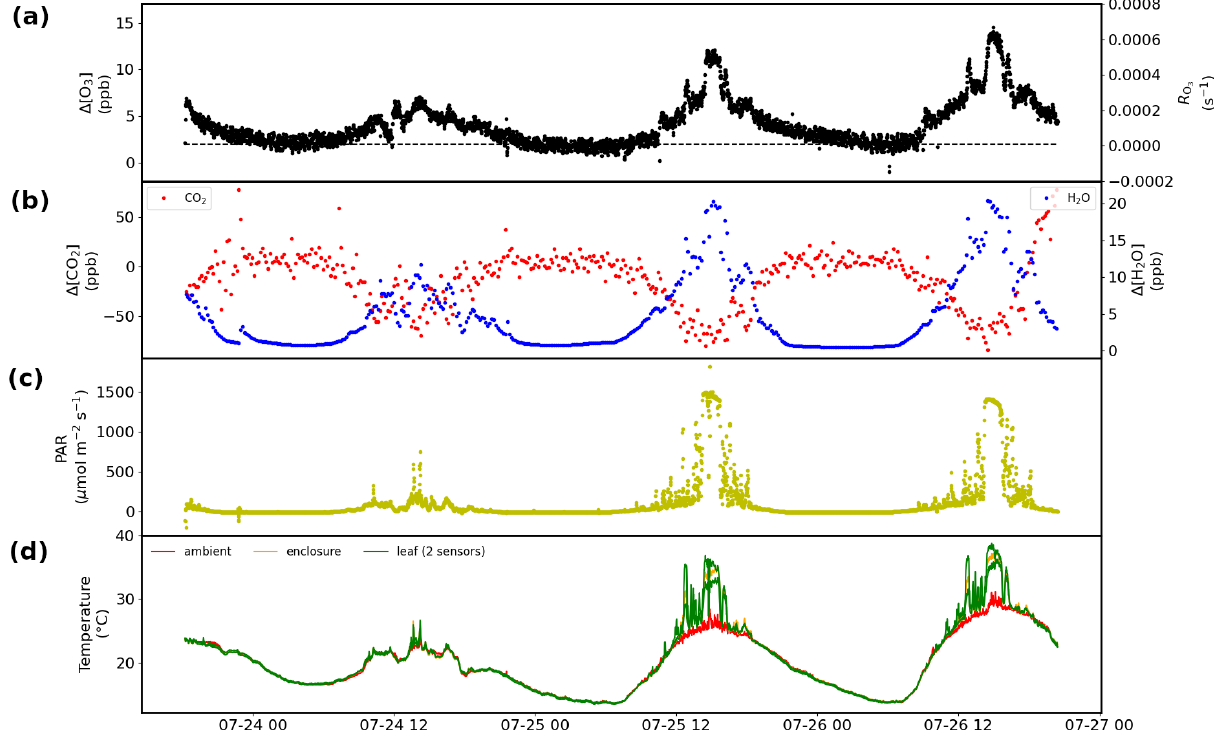
Figure 10. Results obtained over 3d from a branch enclosure experiment on a red oak tree at the University of Michigan Biological Station: (a) results for the (cid:49) [ O 3 ] measurement, with the dashed black line indicating the value of the wall losses and/or background (left) and the corresponding RO 3 (right). (b) Respiration and photosynthesis expressed as the difference in the water (right) and CO 2 (left) mole fractions in the airstream going into and out of the enclosure. (c) Solar photosynthetically active radiation (PAR). (d) Leaf, inside enclosure, and ambient